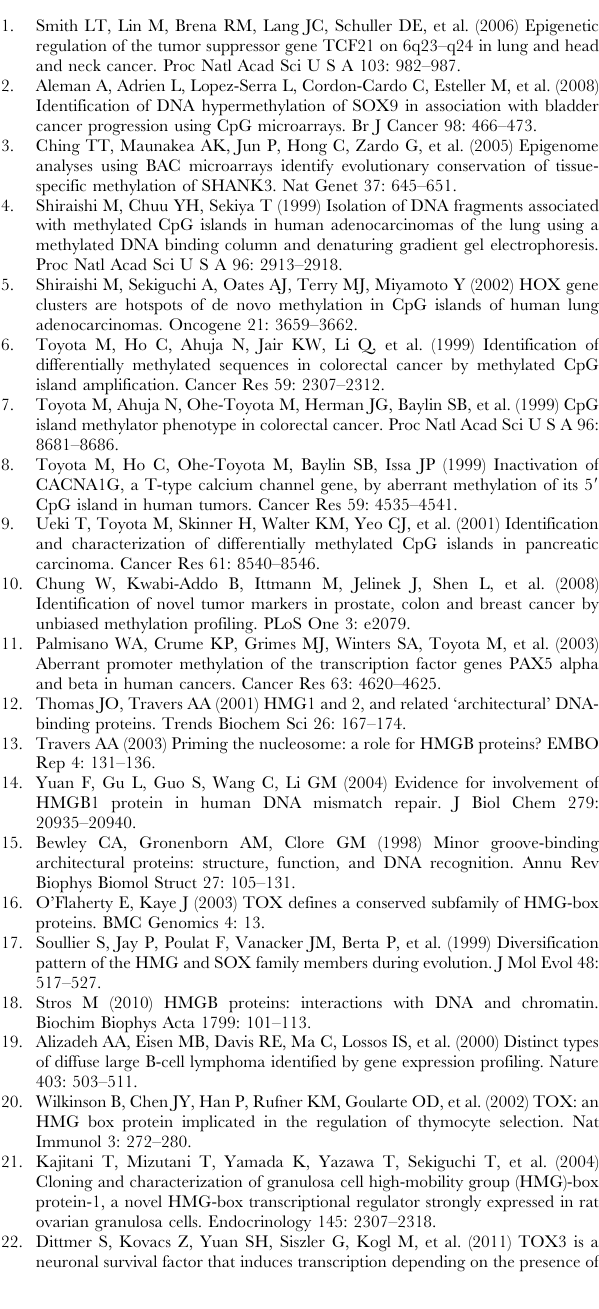
Table S5 Genes with $ 2-fold decrease as a result of TOX2 knockdown. Table S6 Genes with $ 2-fold change as a result of TOX3